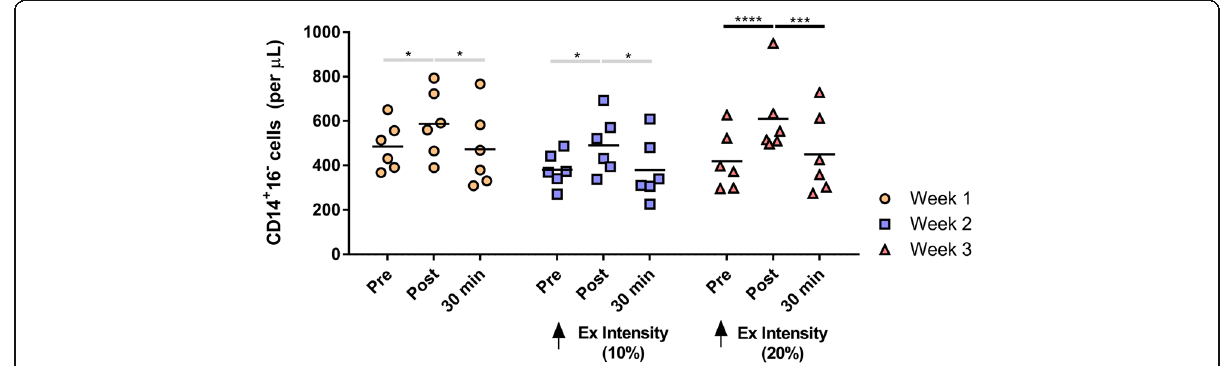
Fig. 11 Circulating numbers of CD14 + CD16 − monocytes during 3 weeks of exercise training ( N = 6). Significant effect of time was detected ( P < 0.0001). Post hoc significance using Tukey ’ s multiple test: * P < 0.05, *** P < 0.001, **** P < 0.0001. No significant main effect of intensity or interaction was observed ( P >